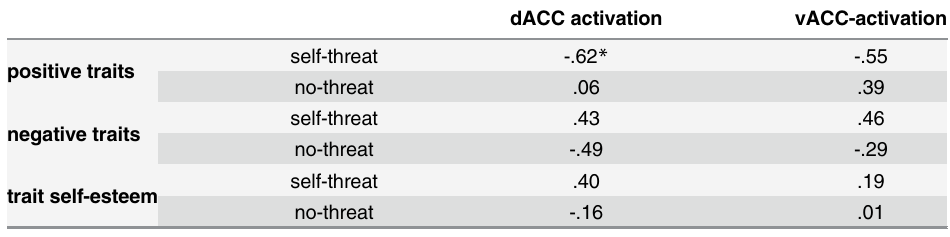
Table 6. Correlations between ROI activation scores and response latencies for self-concept activa- tion and trait self-esteem scores under different conditions (threat vs. no-threat): dACC activation (dorsal anterior cingulate cortex) or vACC activation (ventral anterior cingulate